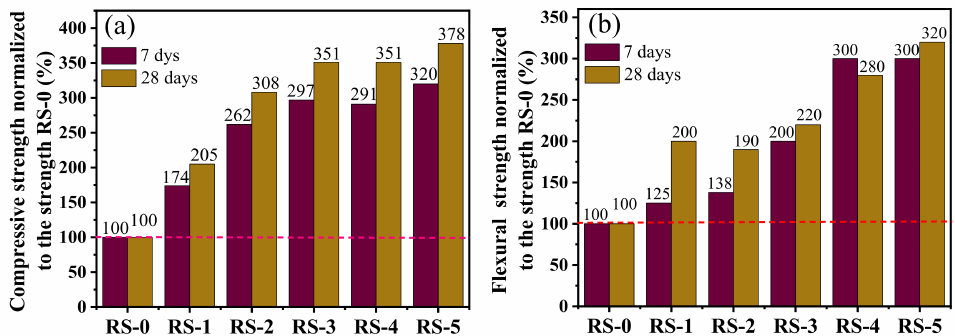
Figure 5. ( a ) Compressive strengths normalized to the strength RS-0; ( b ) flexural strengths normalized to the strength of RS-0.